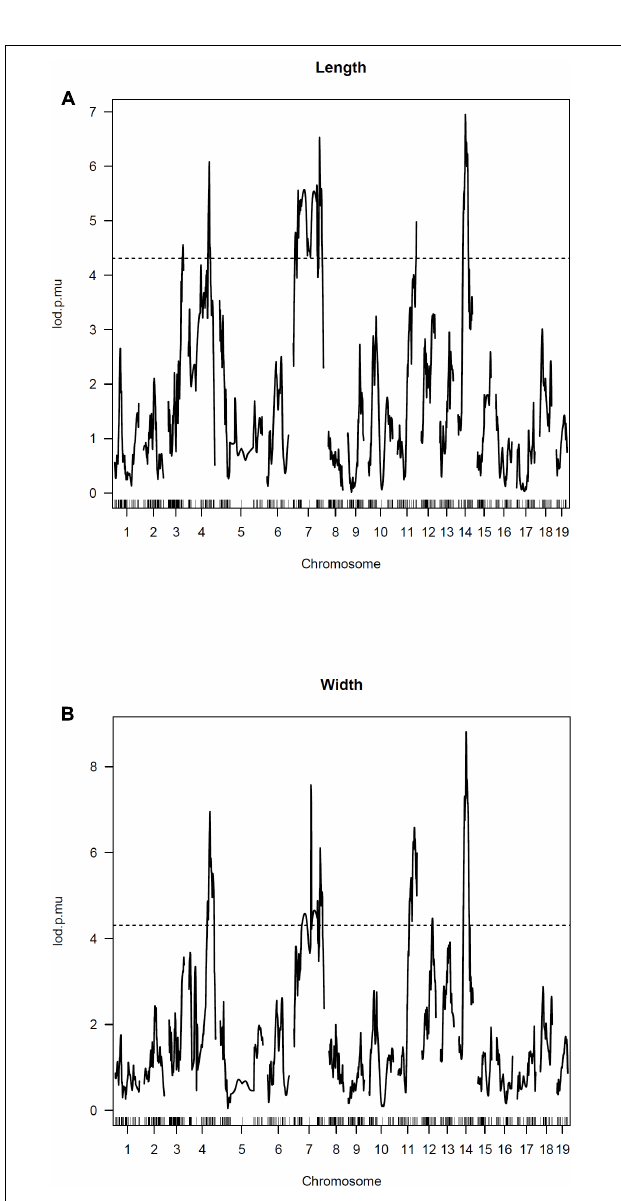
FIGURE 4 | Genomewide scan for IF bone phenotypes. Two part single QTL model was used. LOD score curves for IF bone length (A) and width (B)